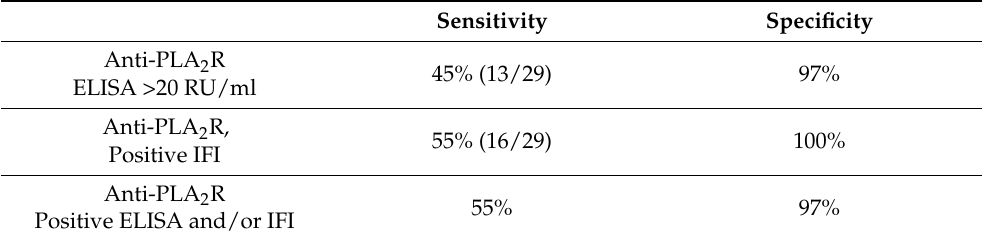
Table 3. Autoantibodies’ profile by anti-PLA2R ELISA and IFI tests in patients with primary MN. Sensitivity Specificity